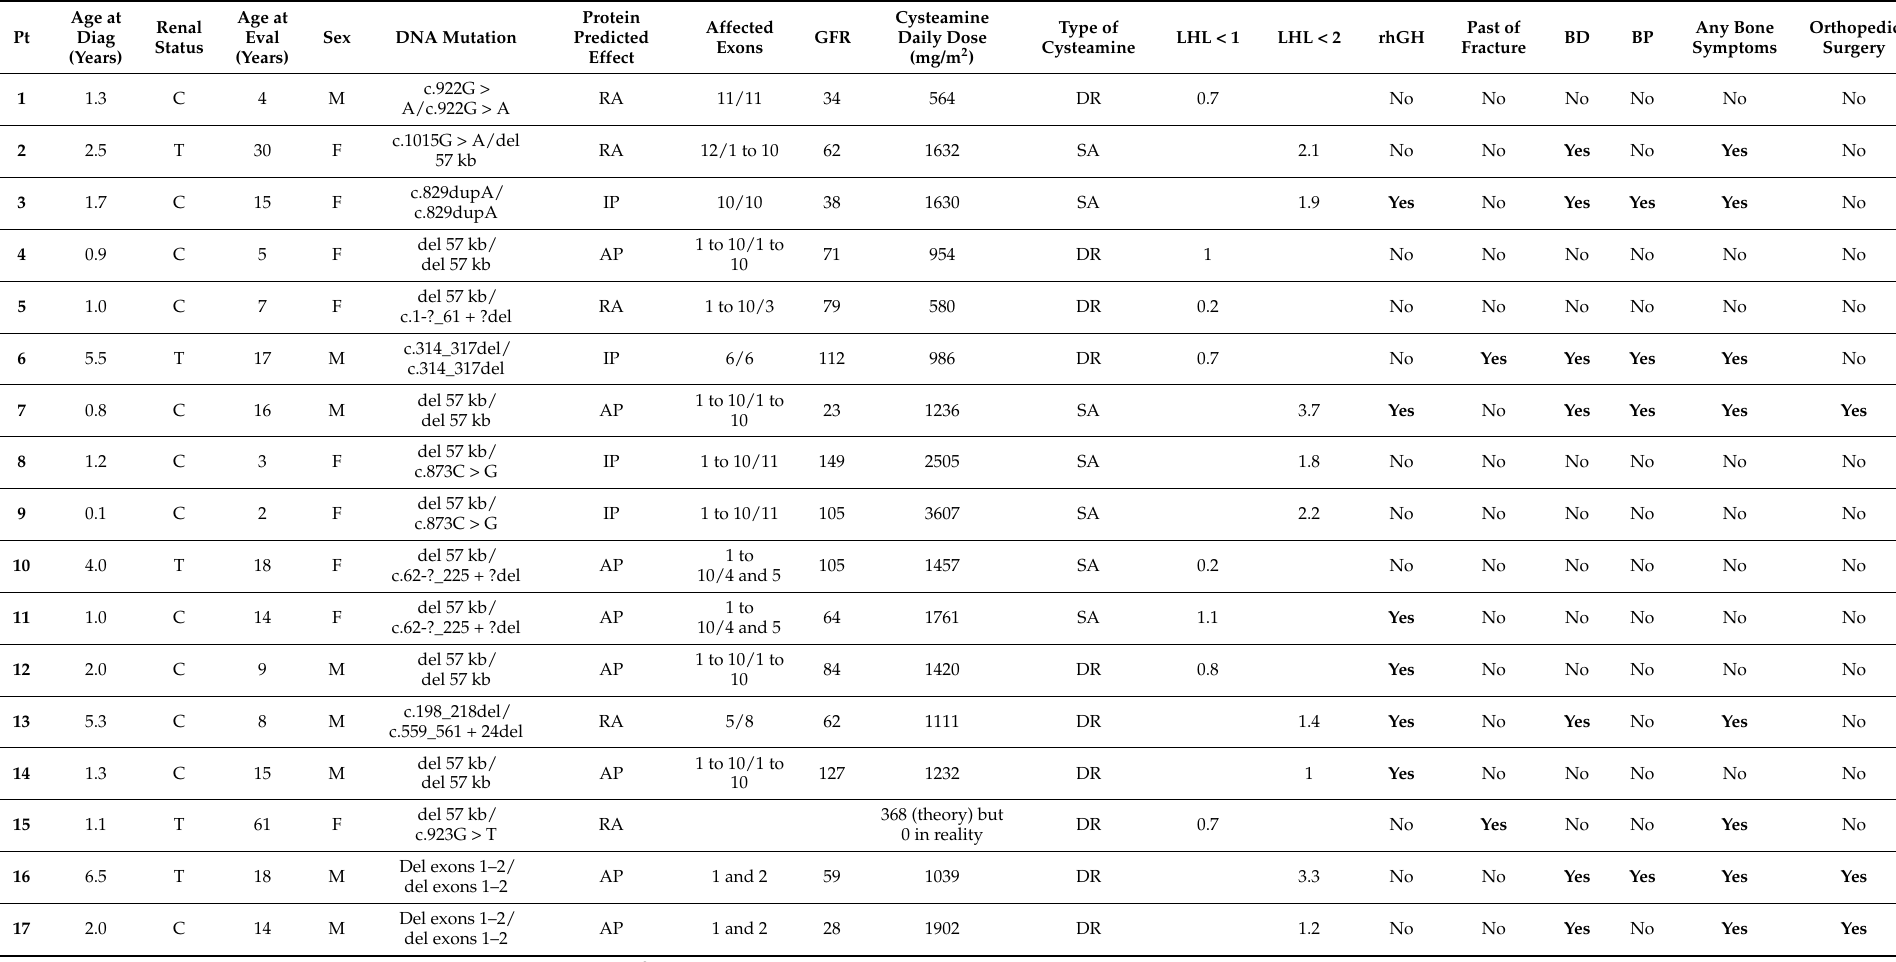
Table 1. Baseline characteristics of